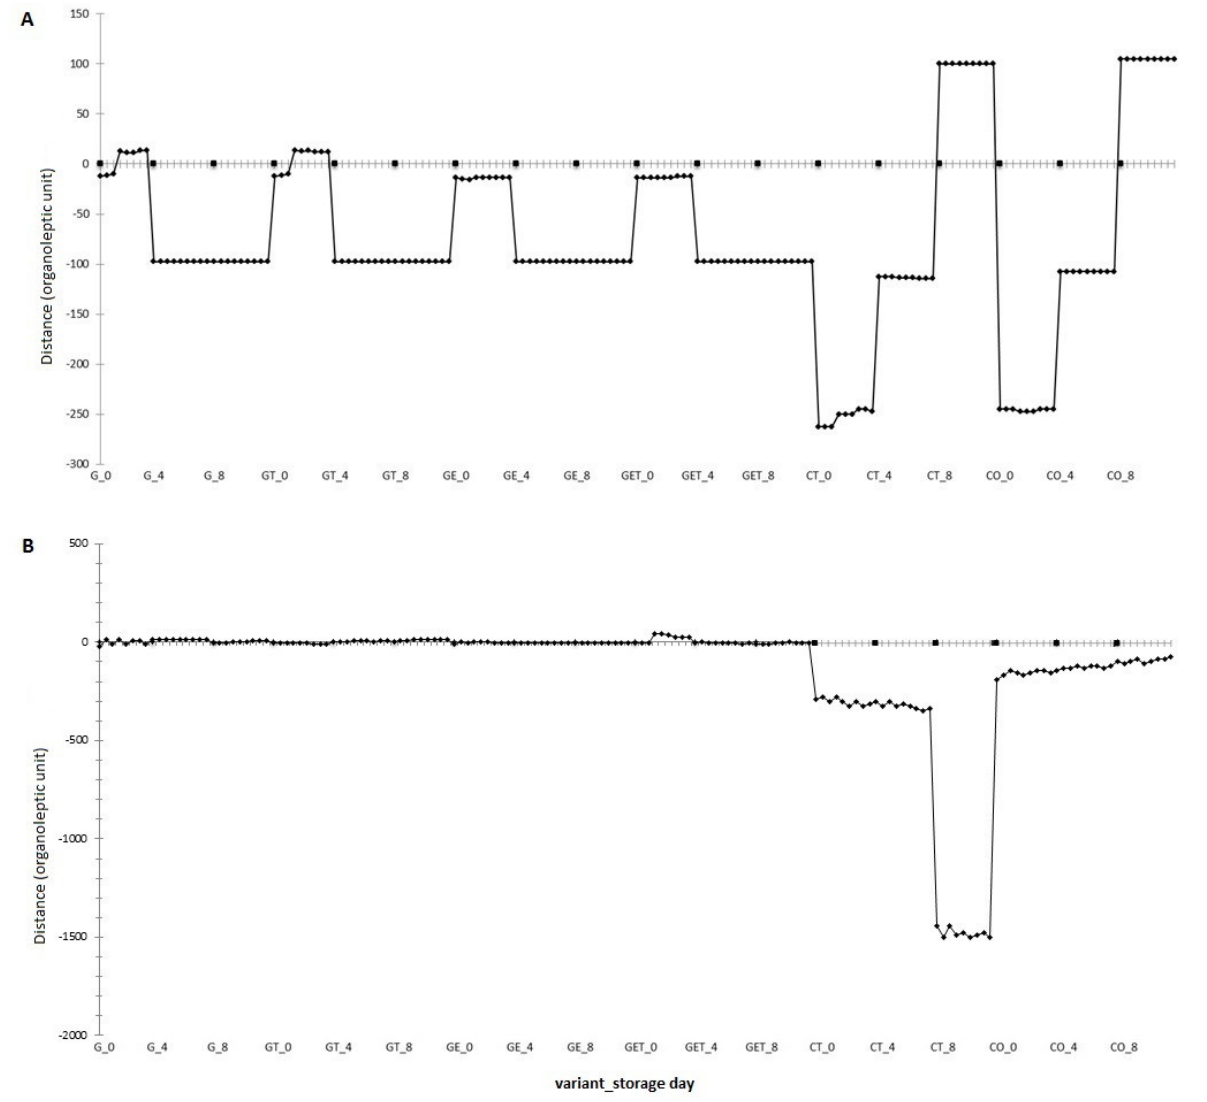
Figure 5. Changes in the volatile compounds profile of raw burgers ( A ); grilled burgers ( B ), after 0, 4, and 8 days of storage (4 ± 1 °C). G—encapsulated oil; GT—encapsulated oil + tallow; GE—encap- sulated oil with aҫai extract; GET—encapsulated oil with aҫai extract + tallow; CT—control with tallow; CO—control with oil.